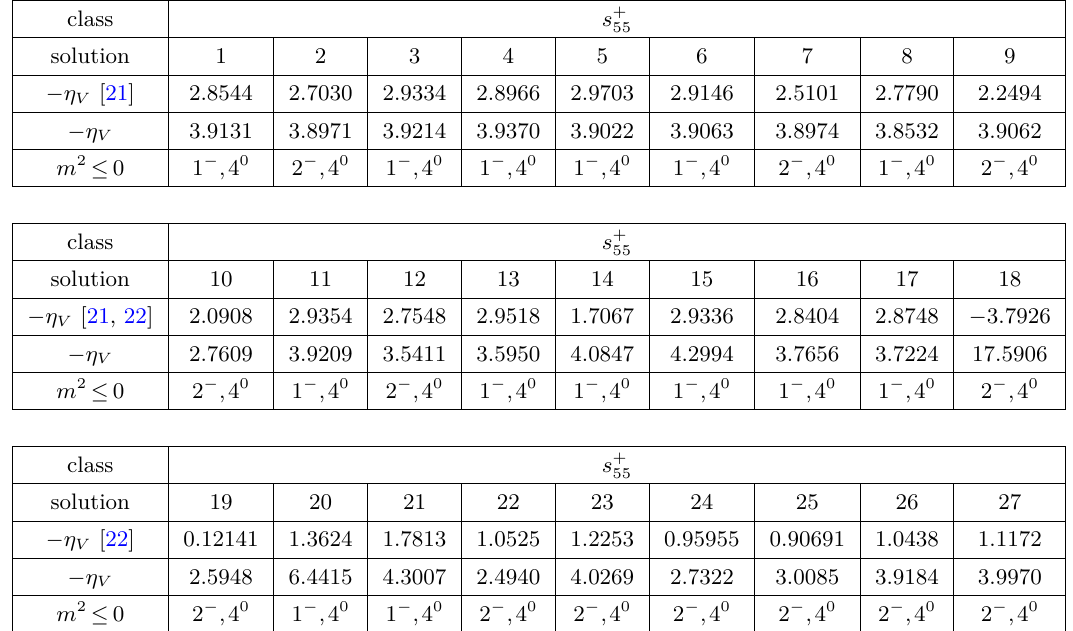
Table 6 . Spectrum information for each de Sitter solution in type IIB. We first provide the value of − η for the fields ( ρ, τ, σ ) obtained in [21, 22], then the one obtained here with the complete V I set of scalar fields of the above dimensional reduction. By i − , j 0 , we also indicate the number j of massless modes and i of tachyons.